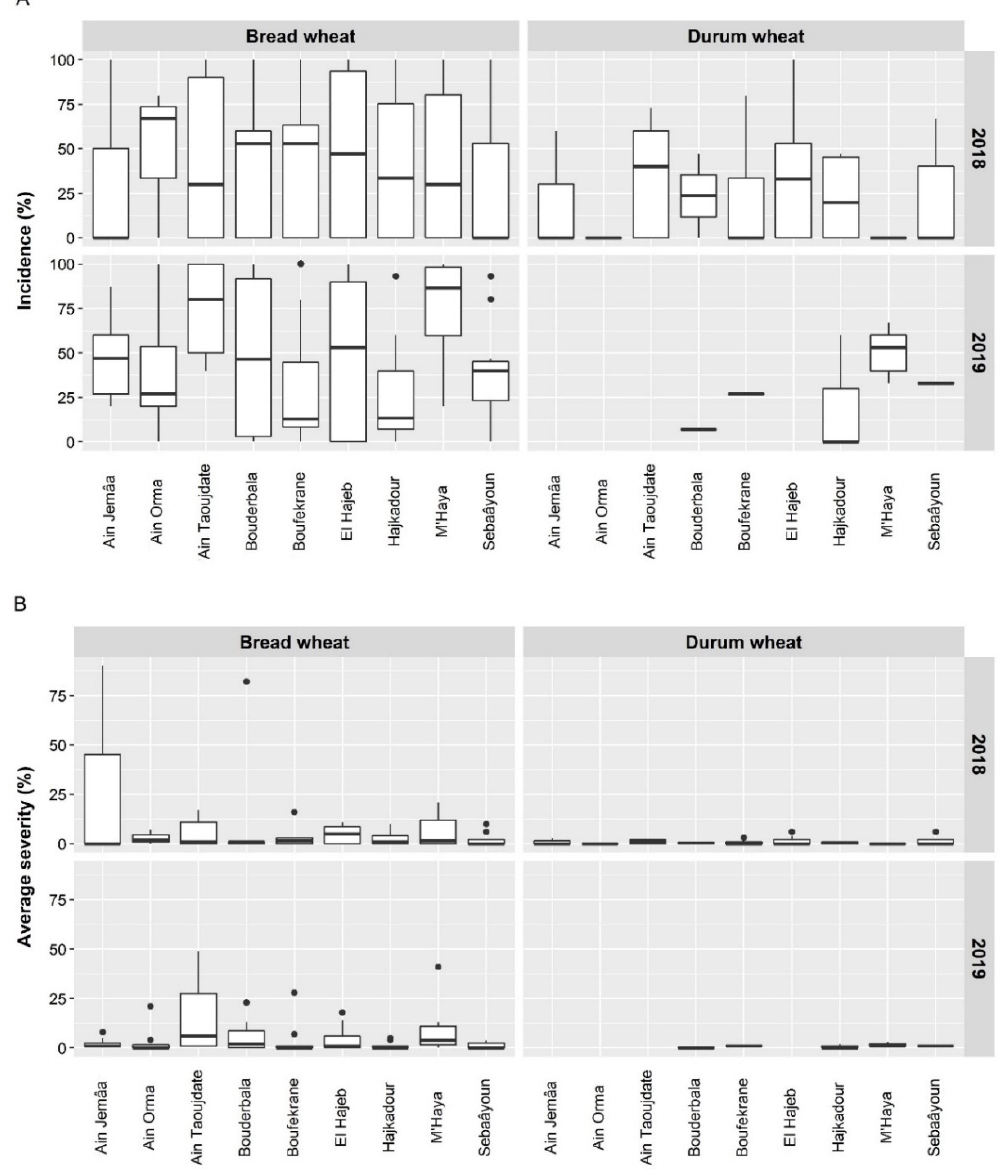
Figure 3. Observed incidences ( A ) and severities ( B ) of wheat stripe rust in bread and durum wheat fields at the surveyed sites in Morocco during the 2017/2018 and 2018/2019 cropping seasons.